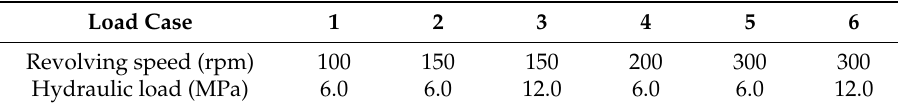
Table 2. Six typical load case combinations for testing.